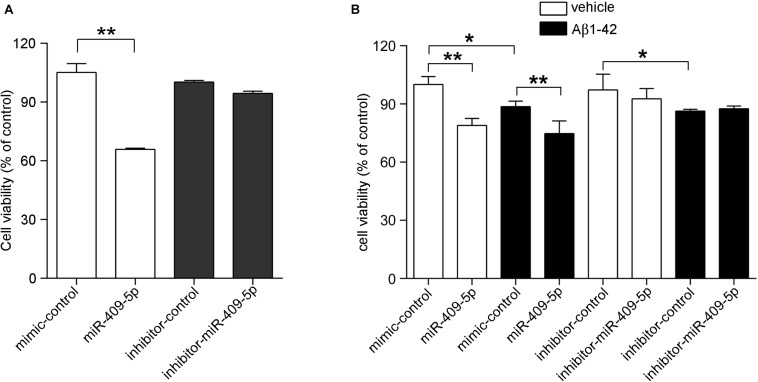
MiR-409-5p and oligomeric Aβ1–42 peptide significantly decreased neuronal viability. (A) Mouse primary cultured hippocampal neurons were transfected with miR-409-5p mimic or inhibitor before culturing. Three days later, the MTS/PMS assay was performed to evaluate the cell viability. (B) Mouse primary cultured hippocampal neurons were transfected with miR-409-5p mimic or inhibitor. Forty-eight hours later, the cells were treated with 10 μM oligomeric Aβ1–42 for another 24 h. MTS/PMS assay was performed to evaluate the cell viability. The results were shown as the mean ± SD (∗p < 0.05, ∗∗p < 0.01). The experiment was repeated independently for three times. Unpaired t-test was used to analyze differences.